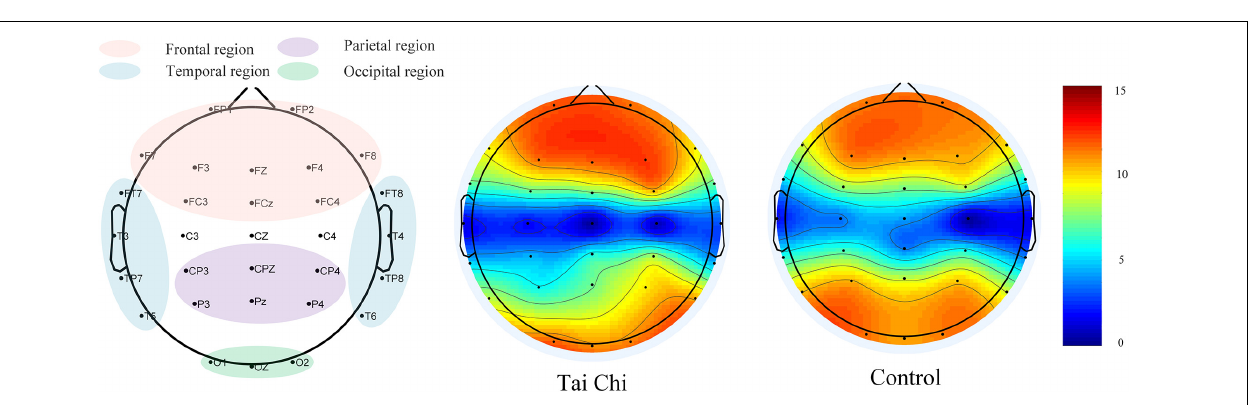
FIGURE 6 | Line chart of nodal degree of each brain region in alpha frequency band of TC group and control group. *Indicated significant difference between groups, p < 0.05, **indicated significant difference between groups, p < 0.01.